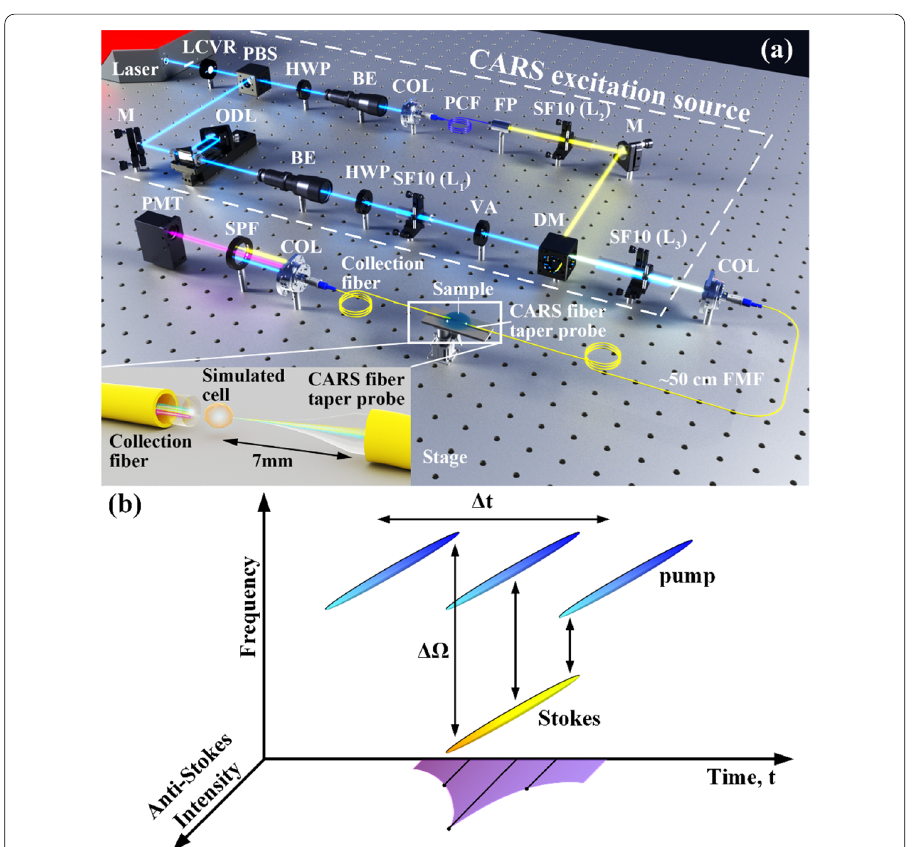
Fig.2 a Schematic diagram of the SSFS-based CARS system with composite wavelength tuning. LCVR: liquid crystal variable retarder, PBS: polarization beam splitter, HWP: half-wave plate, BE: beam expander, FP: fiber-port, PM-PCF: polarization-maintaining photonic crystal fiber, COL: collimator, SF10: SF10 dispersion glass rod, l 1 5 cm, l 2 15 cm, l 3 15 cm, M: mirror, ODL: optical delay line, VA: variable optical attenuator, = = = DM: long-pass dichroic mirror, SPF: short-pass filter, PMT: photomultiplier tubes. b Schematic diagram of the frequency difference tuning of the linearly chirped pump and Stokes pulse in spectral focusing by tuning relative time